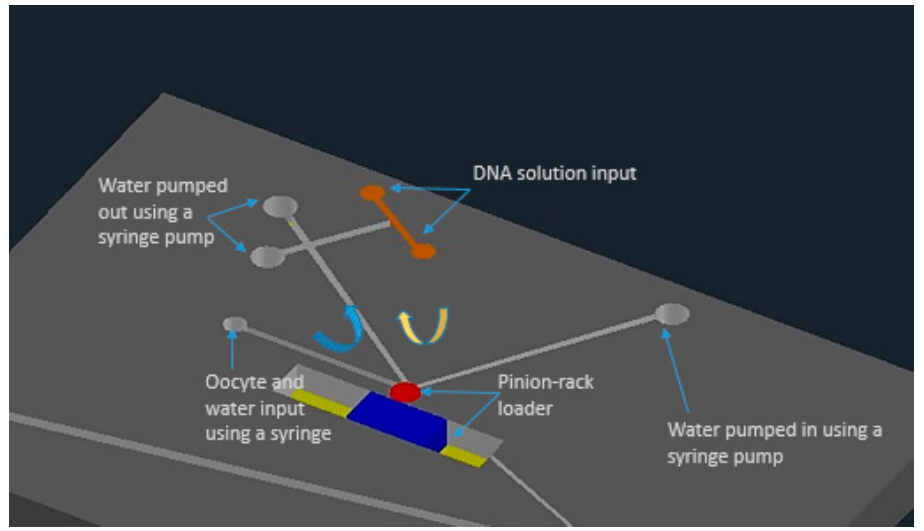
Figure 2. The schematic of the microfluidic chip for microinjection with built-in micro-channels and controlled water flow using syringe pumps. Figure has been redrawn from ref. [62].